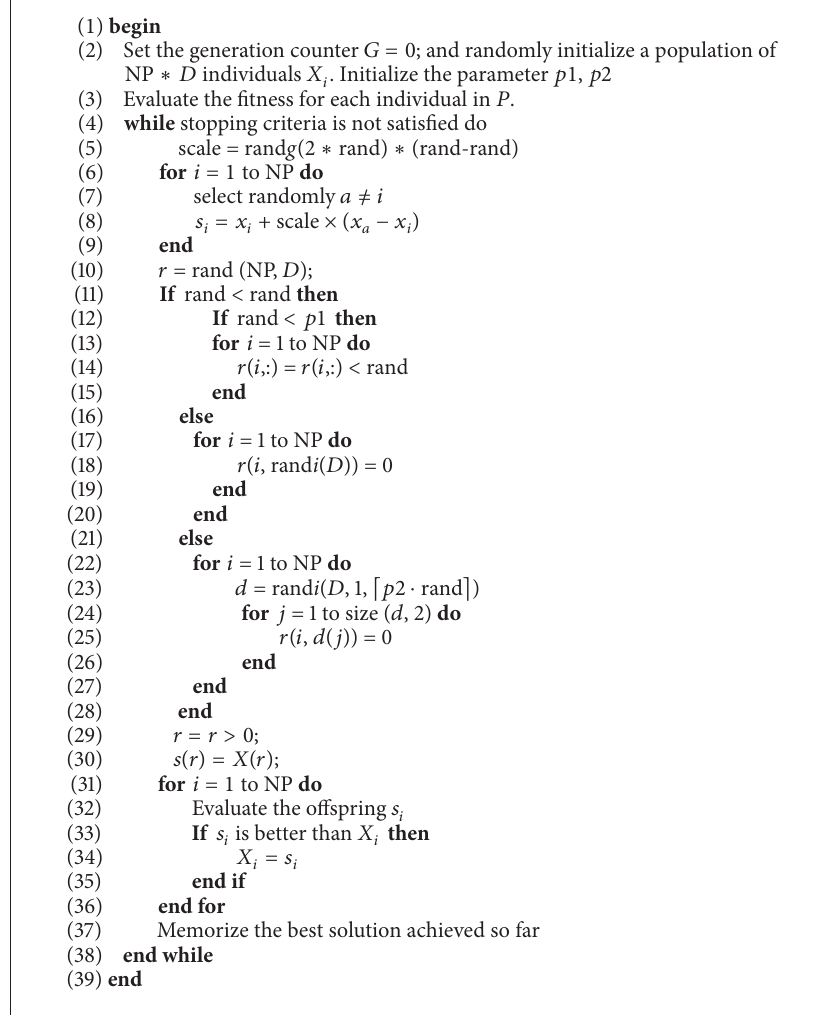
Procedure 1: Algorithm description of Differential search